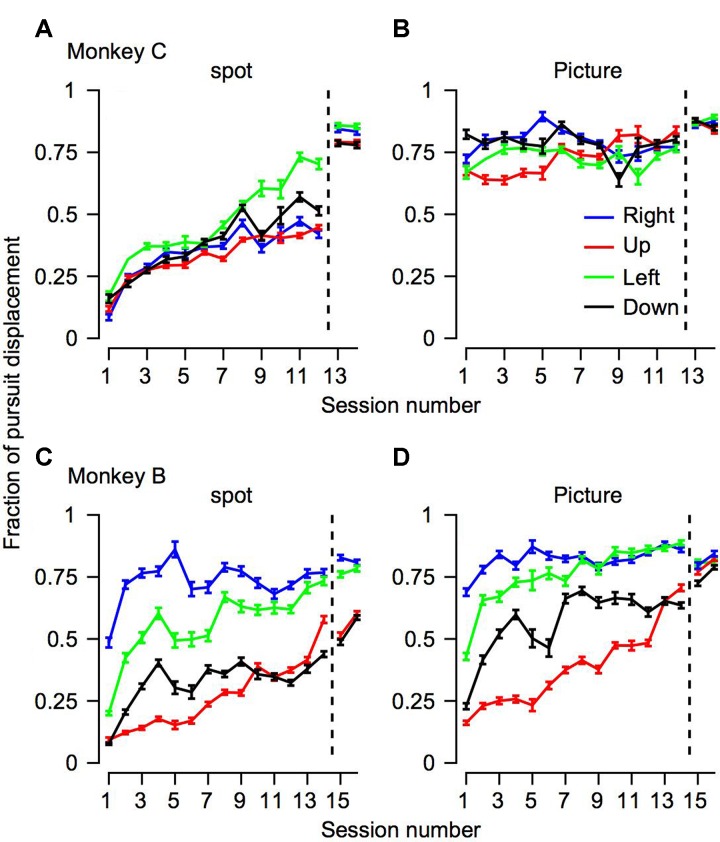
The progression over training days for the fraction of pursuit displacement across all the trials. The progression over training days of the fraction of position displacement with pursuit. The horizontal axis represents the session number, sessions to the right of the vertical dotted line were recorded after extensive training on pursuit tasks. The top (A,B) and bottom (C,D) plots shows data for Monkeys C and B. Different columns correspond to the different target conditions and colors represent the movement directions.